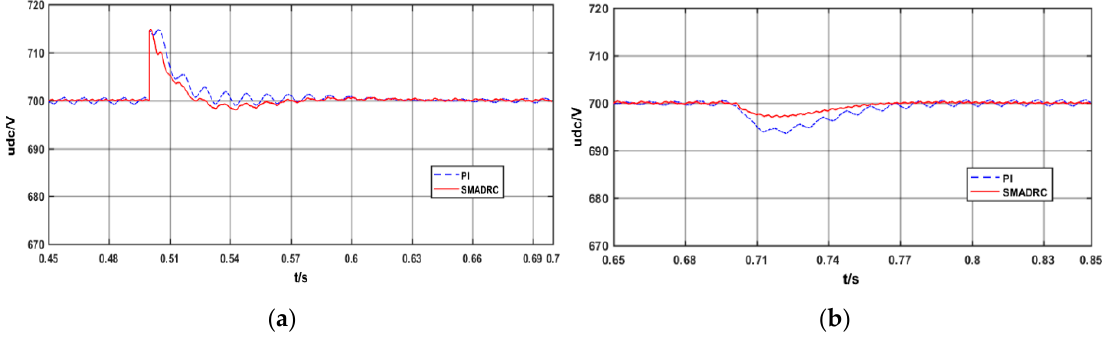
suitable for distribution networks with distributed power.